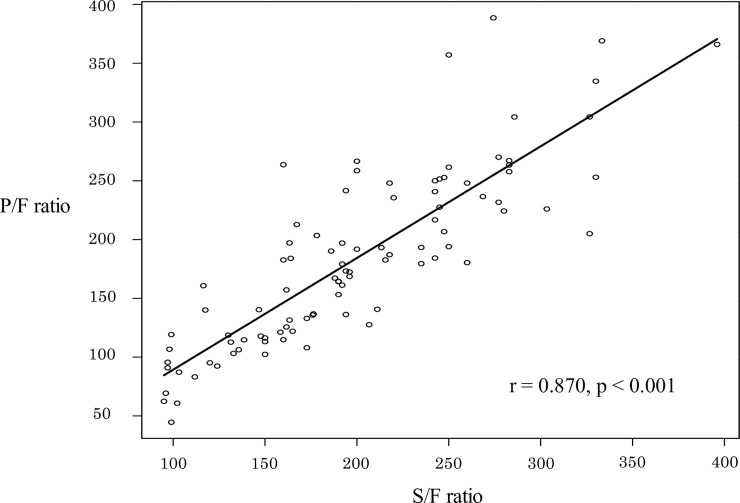
The relationship between the SpO2/FiO2 (S/F) and PaO2/FiO2 (P/F) ratios.S/F ratio showed significant linear correlation. S/F ratio = 60.9 + 0.75 × P/F ratio (p < 0.001; r = 0.87).